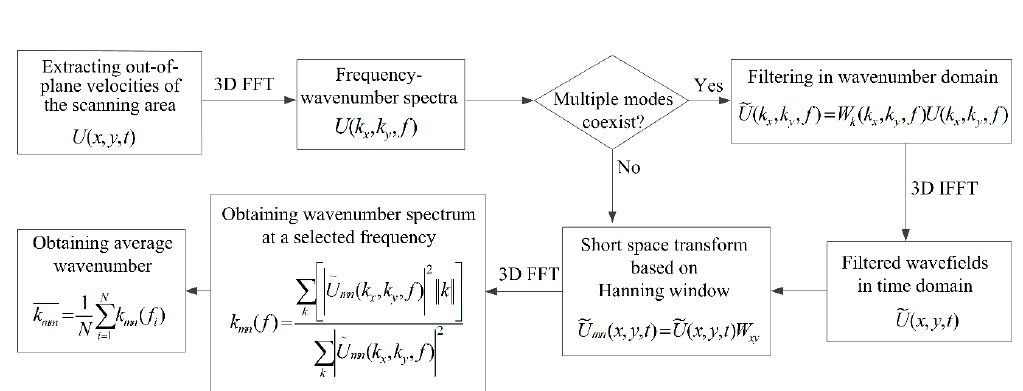
Figure 3. Flow chart of the local wavenumber approach.